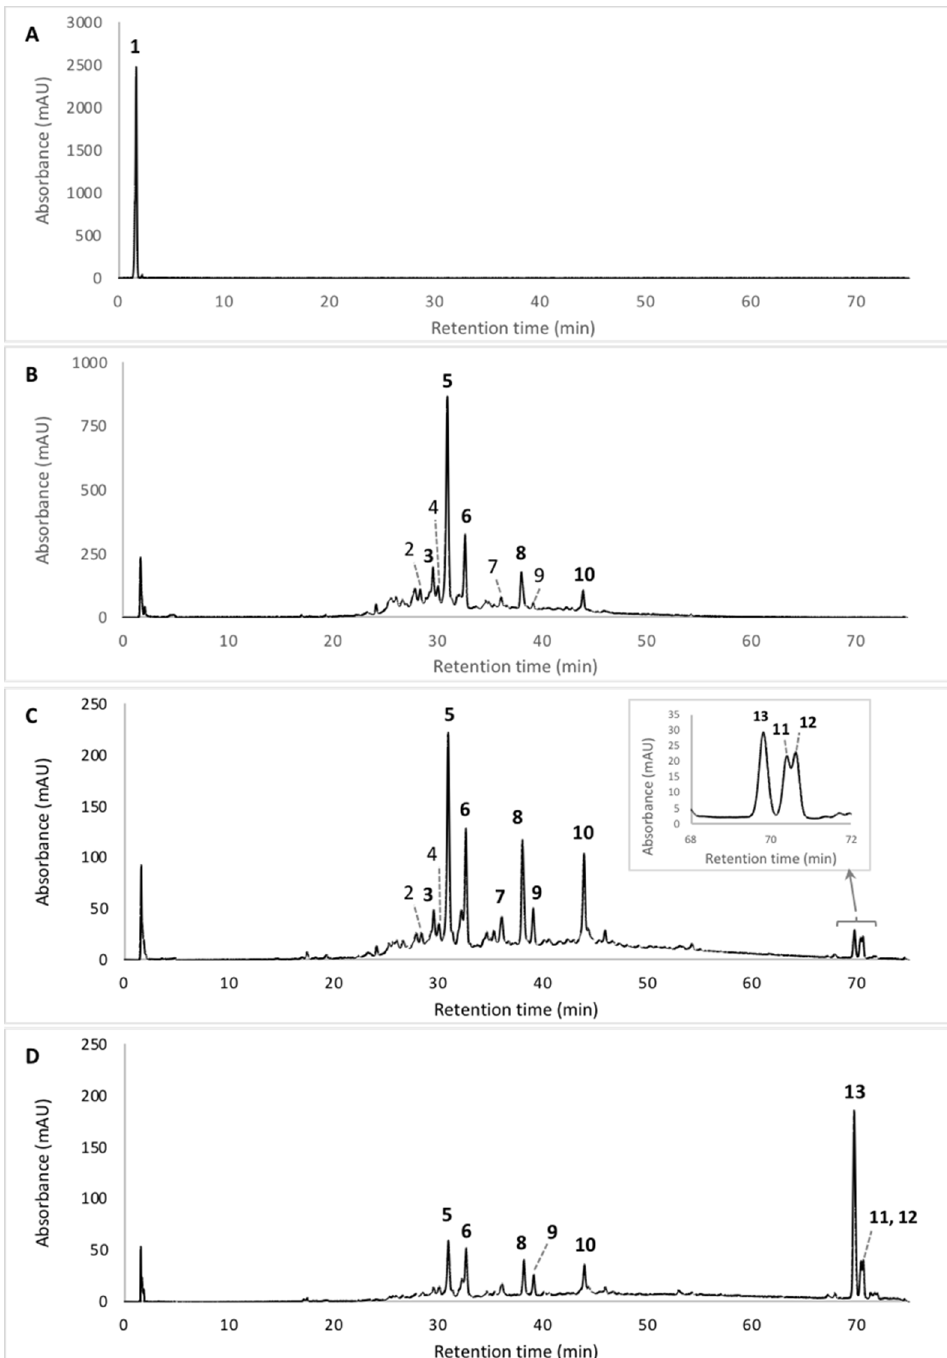
Figure 3. LC-DAD chromatograms of the fungal extracts from the mycelium of the marine-derived Talaromyces sp. 30570 strain cultivated in Potato Dextrose Broth (PDB). Pigments were extracted by pressurized liquid extraction: ( A ) water, ( B ) 50% aqueous methanol, ( C ) 50% aqueous ethanol, or ( D ) by pure methanol as extraction solvent. Assignment of the azaphilone red pigments 1 – 12 and ergosterol 13 were done by UV-visible and HRMS spectra. See Table 1 for the identification of the molecules.